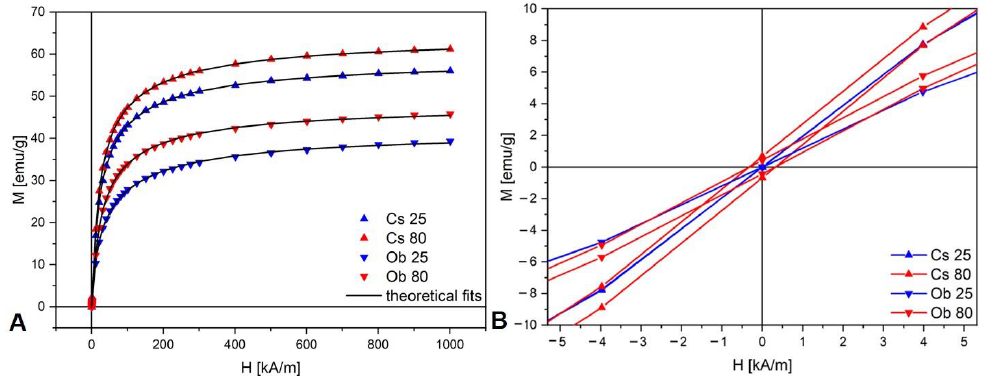
Figure 6. ( A ) First magnetization curves of the samples, and ( B ) hysteresis curves of the samples